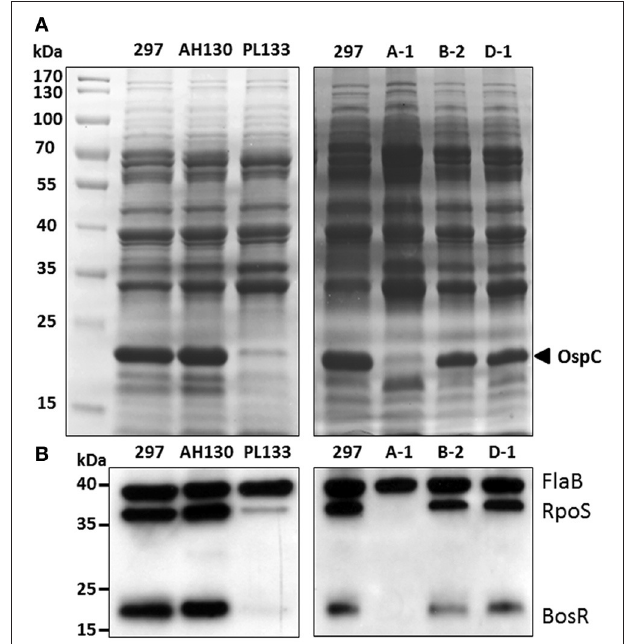
FIGURE 4 | Levels of RpoS and BosR in clones with different OspC levels. (A) SDS-PAGE. The band corresponding to OspC is labeled at the right. (B) Immunoblot. Whole cell lysates of B. burgdorferi clones were separated and probed with a mixture of α -FlaB, α -RpoS and α